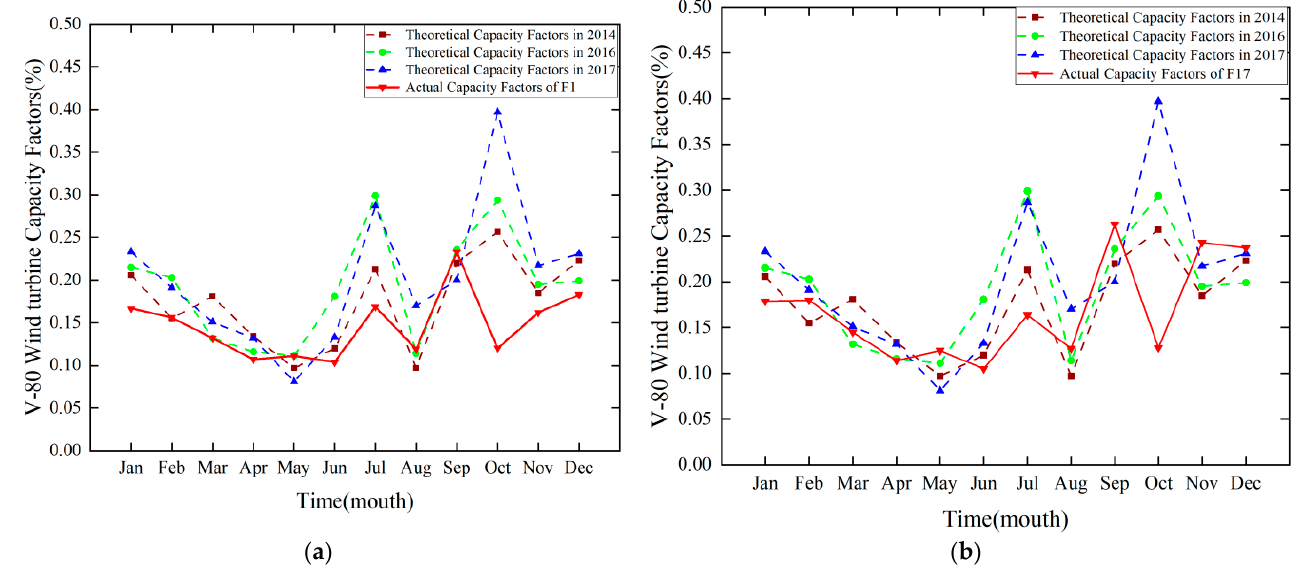
Figure 11. Comparison of actual and theoretical capacity factors: ( a ) F1 and ( b ) F17.